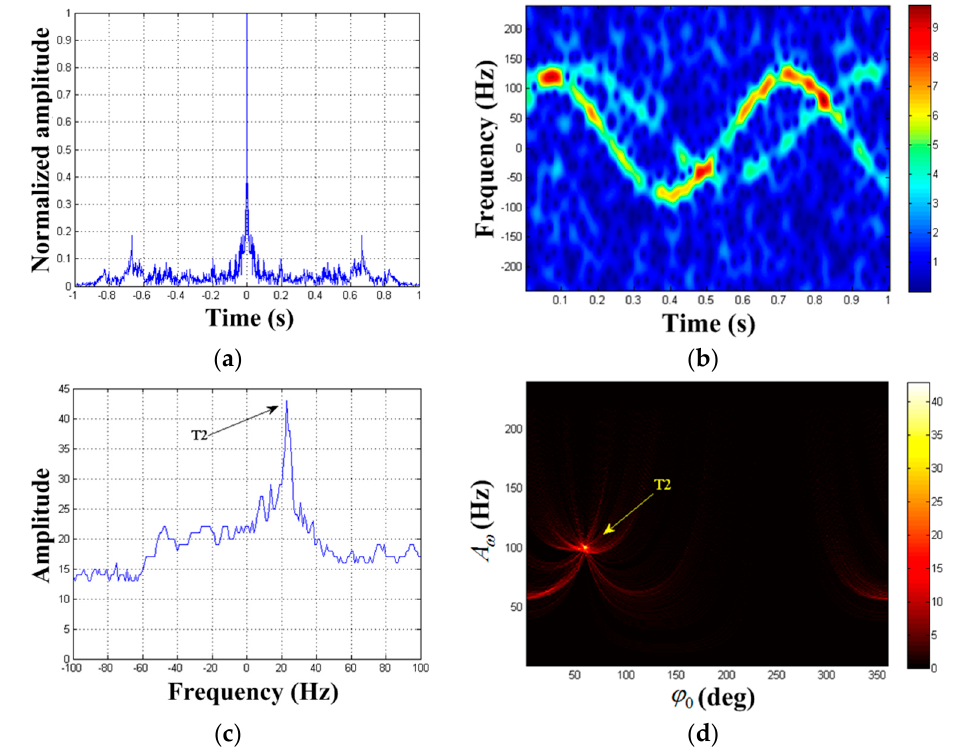
( ) x t . ( a ) Autocorrelation result of a 1 (cid:8) (cid:9) { } A 2 , ϕ 2 domain when F 2 = 21Hz. , A ϕ domain when 2 21Hz F = . 2 2